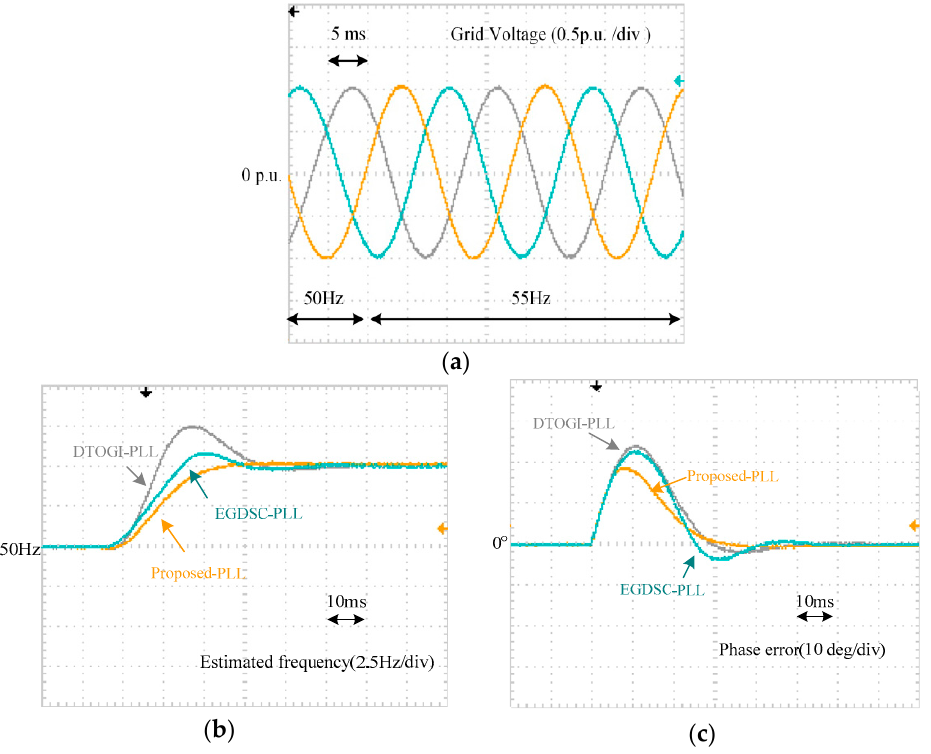
Figure 17. Experimental waveforms when the grid voltage undergoes a frequency step change of +5 Hz. ( a ) is the grid voltage waveform, ( b ) is the estimated frequency waveform, and ( c ) is the phase error waveform.